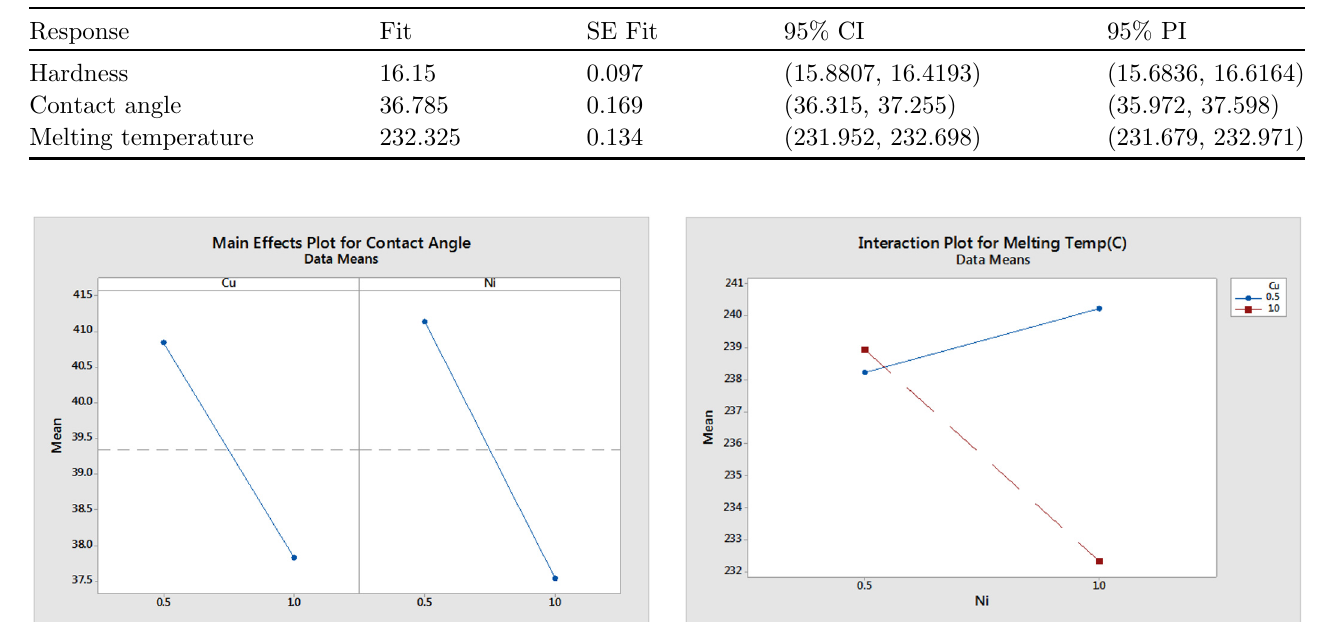
Table 14. Best fi t solution.